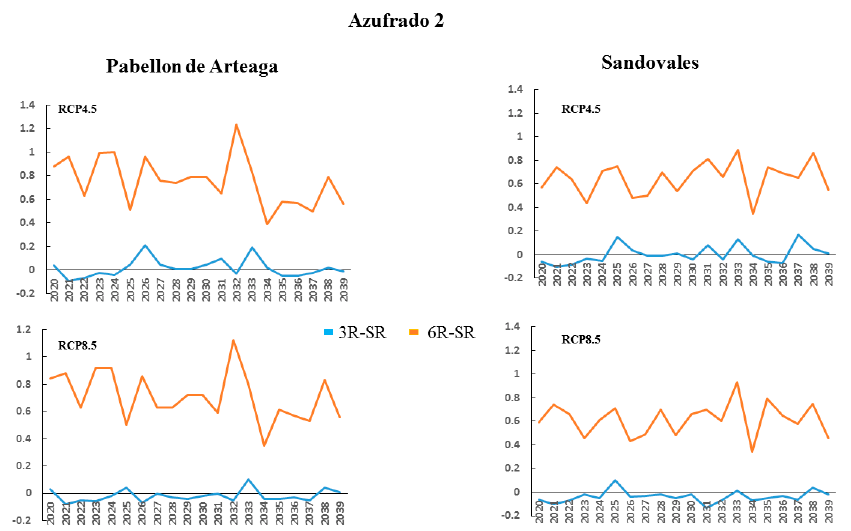
Figure 8. Forecasted seed yield (Mg ha − 1 ) increase or decrease for 2020–2039 under climatic scenarios RCP4.5 and RCP8.5 for Azufrado 2 (growth habit I) common bean cultivar (growth habit I) under sowing densities of 145,000 (3R) and 260,000 (6R) plants ha − 1 compared to a baseline sowing density of 90,000 plants ha − 1 (SR) under rainfed conditions in the semi-arid temperate highlands of Pabellon de Arteaga and Sandovales in Aguascalientes.